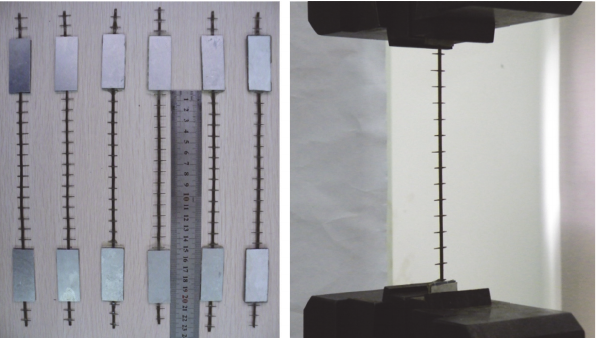
Figure 4: Specimens and tensile test of BFRP bundle.